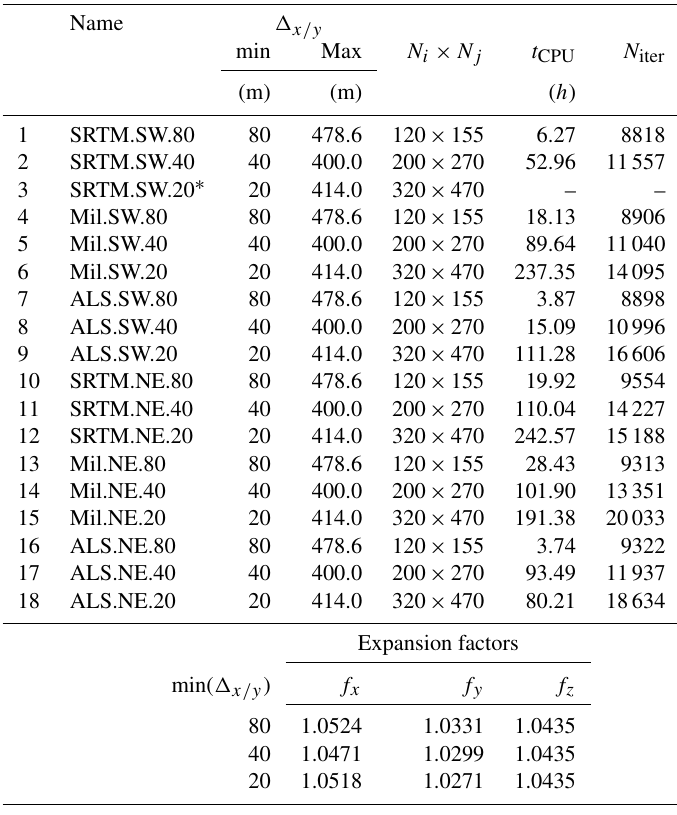
Table 5. Computational meshes ( (cid:49)z Min = 2m).